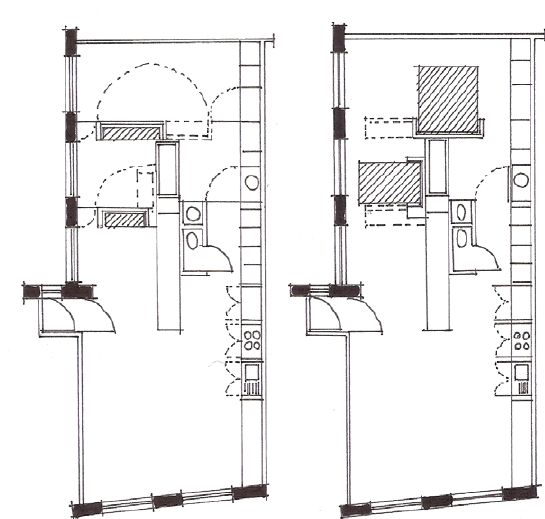
Figure 4. Embedding beds and other furniture in the walls as the edges of the rooms to allow multiple activities occur in the center, sample 33, ‘The Transformable Apartment’, Britain,